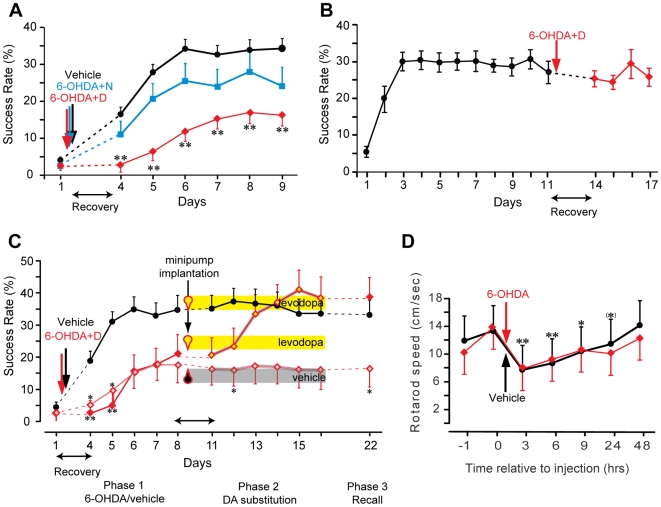
Dopamine (DA) release in M1 is necessary for optimal motor skill acquisition but not for movement execution.(a) Learning curves for sham-lesioned rats (black, vehicle), rats with dopaminergic terminals destroyed (red, 6-OHDA+D), and rats with noradrenergic terminals destroyed (blue, 6-OHDA+N). Cortical injections (vertical arrows) were performed following an initial training session to determine paw preference. After 3 days of recovery from surgery (horizontal arrow, necessary interval determined in d) rats were trained for 6 successive days. The success rate of skill acquisition was significantly impaired in animals with without dopaminergic terminals but not in animals without noradrenergic terminals (** p<0.05). (b) DA is not required for task performance because elimination of dopaminergic terminals in M1 (red, vertical arrow) in rats that already acquired the reaching skill (black) did not affect reaching performance. (c) Learning impairment is restored with DA substitution (administration of its precursor levodopa). Rats received cortical injections of 6-OHDA+D and were trained comparable to a): As compared with sham-lesioned animals (vehicle-injected, black), the two groups without dopaminergic terminals in M1 (6-OHDA+D-injected, red) demonstrated a learning impairment – phase 1. Rats were then implanted with minipumps (drops): 50% of DA terminal deficient rats received vehicle (grey) and 50% received levodopa (yellow) during the entire second training period, sham-lesioned rats received levodopa – phase 2. Learning was restored in DA-substituted rats underlining the importance of DA for skill acquisition. Minipumps were then removed and all rats were examined for task recall after 6 days of rest. DA is not required to recall an already learned skill as indicated by unchanged performance levels in all groups. (d) Cortical injections independent of whether 6-OHDA or vehicle was used transiently impair locomotor function. Rotarod tests were performed in vehicle- (black) and 6-OHDA (red) injected rats. Parallel deficits indicate that reduced rotarod speed results from injection or surgery and not from the drug itself. Results were used to determine the recovery period following surgery (horizontal arrows in a-c).